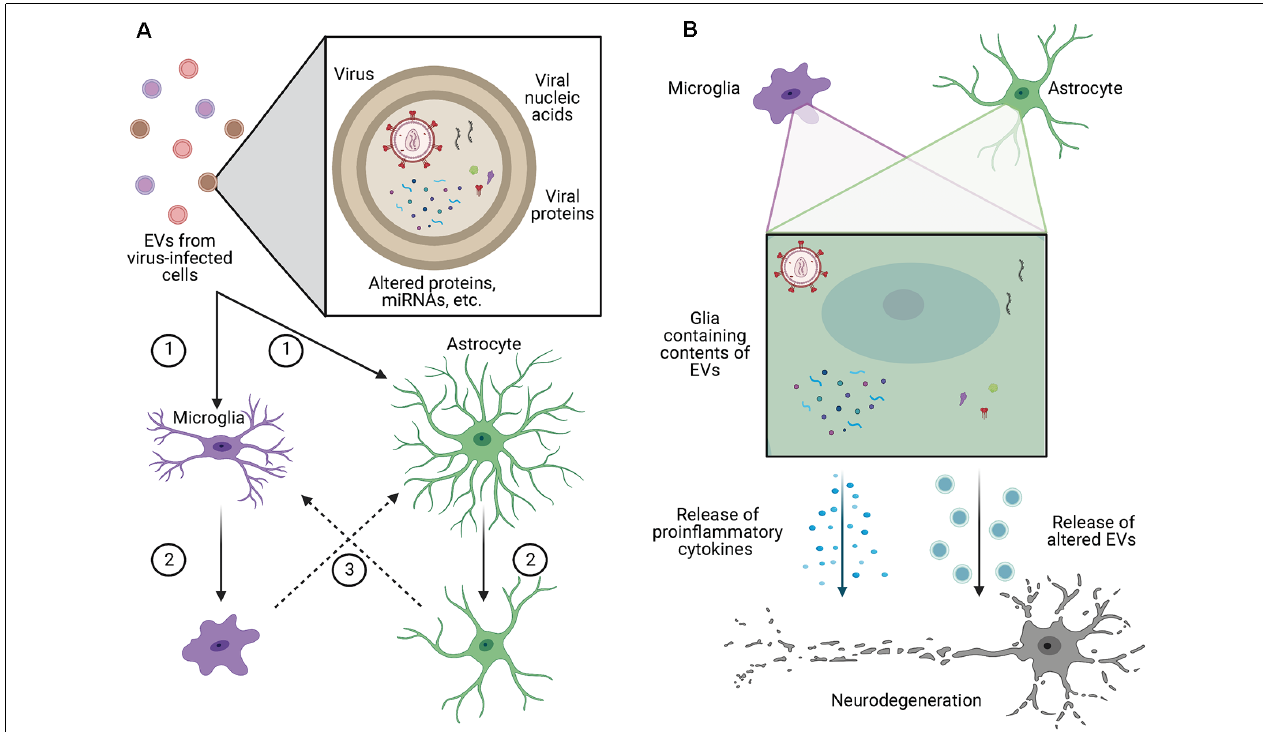
FIGURE 2 | EVs alter glial phenotypes and contribute to neurodegeneration. (A) EVs from virus-infected cells may contain competent virus, viral nucleic acids, viral proteins, or contents which have been altered by viral infection of the cell. These EVs are (1) taken up by microglia or astrocytes causing (2) those cells to take on a more proinflammatory phenotypes which can (3) cause the activation of other surrounding glia. (B) Microglia and astrocytes containing the contents of EVs from virus-infected cells release proinflammatory cytokines as well as increased volumes of EVs with altered contents, both of which have been shown to cause toxic effects in neurons. Figure created with